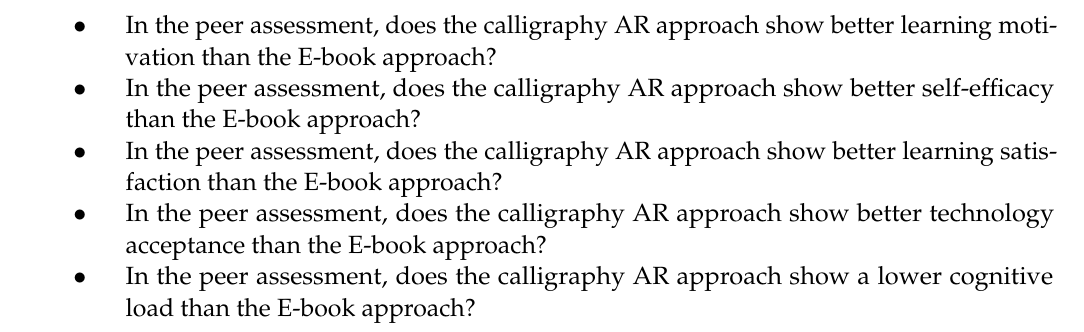
Figure 2. Schematics showing the operation of the calligraphy AR. Figure 3. The experimental group of elderly participants using calligraphy AR.